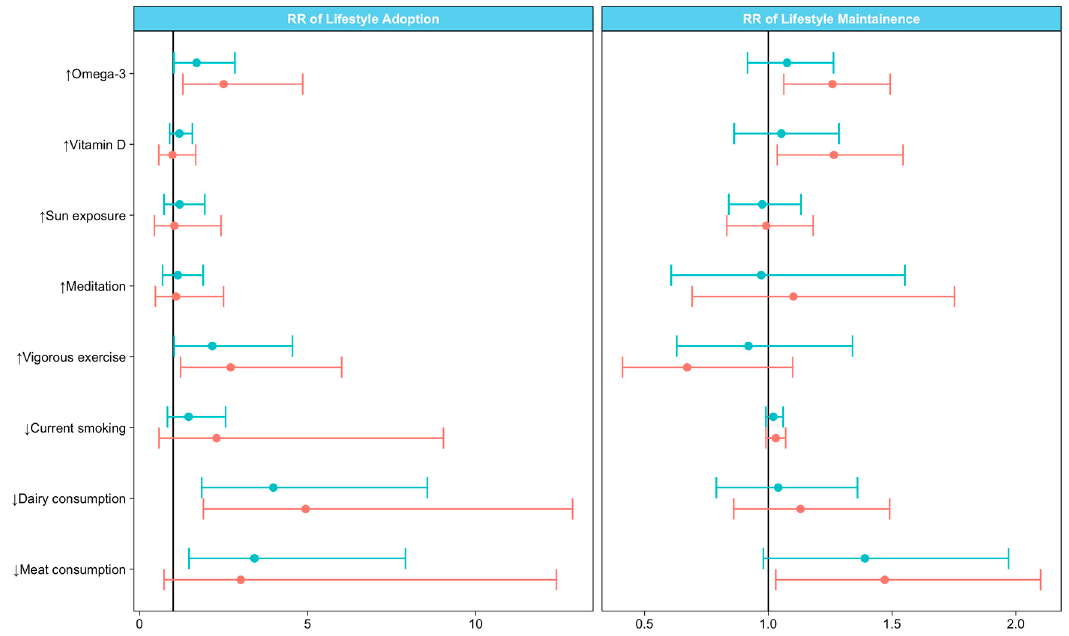
Figure 1. Associations of resource engagement with modifying lifestyle behaviours. Relative risk (RR) estimates for adoption and maintenance of lifestyle behaviours are illustrated by resource engagement levels (none, black with RR = 1; medium, blue; high, orange). Arrow direction indicate recommended lifestyle behaviour (upward = increase, downward = no).